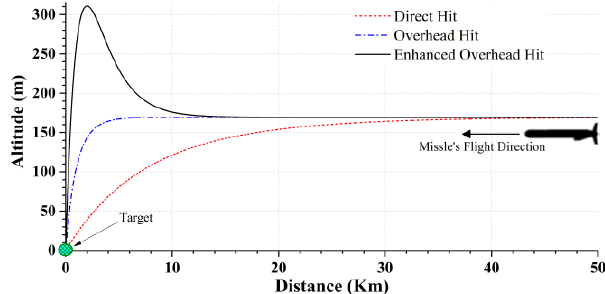
Figure 1. Different and possible scenarios hitting targets by cruise